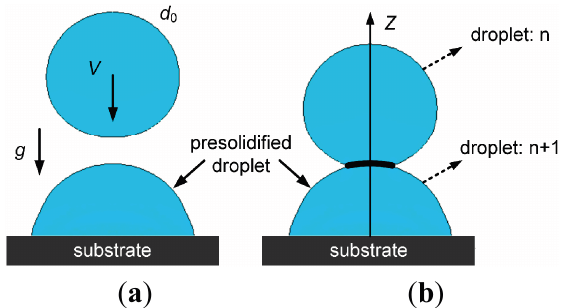
Figure 1. Schematic of the pileup process in metal droplet manufacturing. ( a ) An impinging droplet will be deposited on the top of a solidified droplet perpendicularly. ( b ) Spreading and solidifying of the impacted droplet on the presolidified